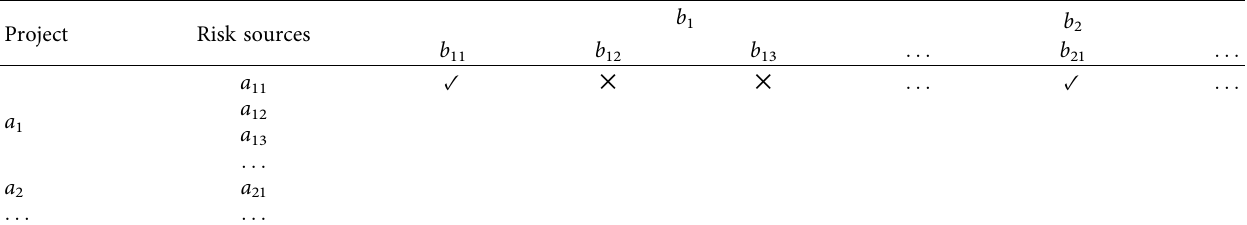
Table 4: Survey on safety risk sources of bridge